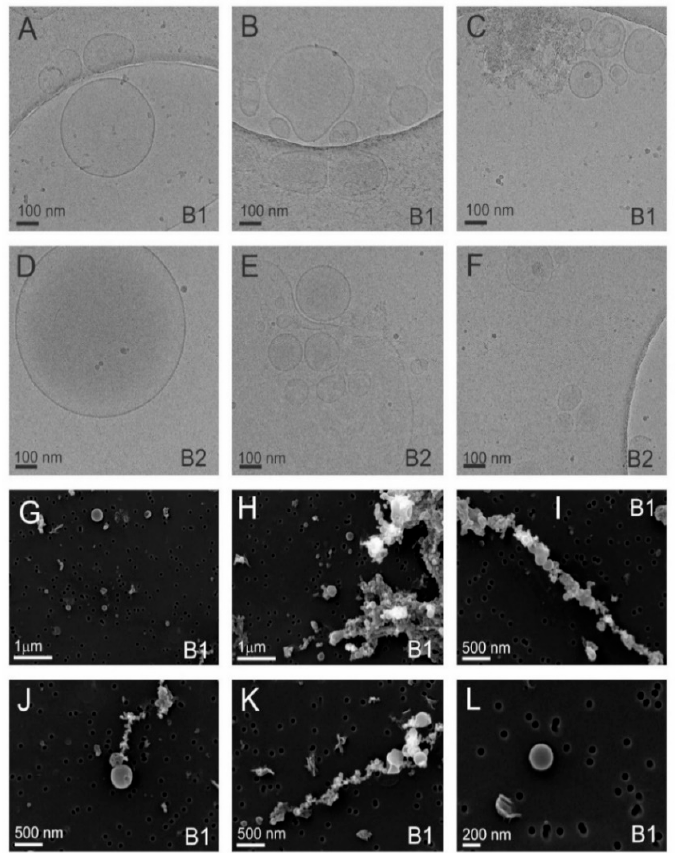
Figure 7. Cryo-TEM and SEM images of selected nanovesicles in the low (B1)—and high (B2)—density sucrose gradient-separated samples isolated from the tomatoes homogenate. Cryo-TEM im- ages ( A – F ) show the presence of amorphous material as well as of vesicles enclosed by a bilayer membrane. SEM images ( G – L ) show the presence of particles with smooth shape that are character- istic for membrane-enclosed entities without internal structure—i.e., vesicles.